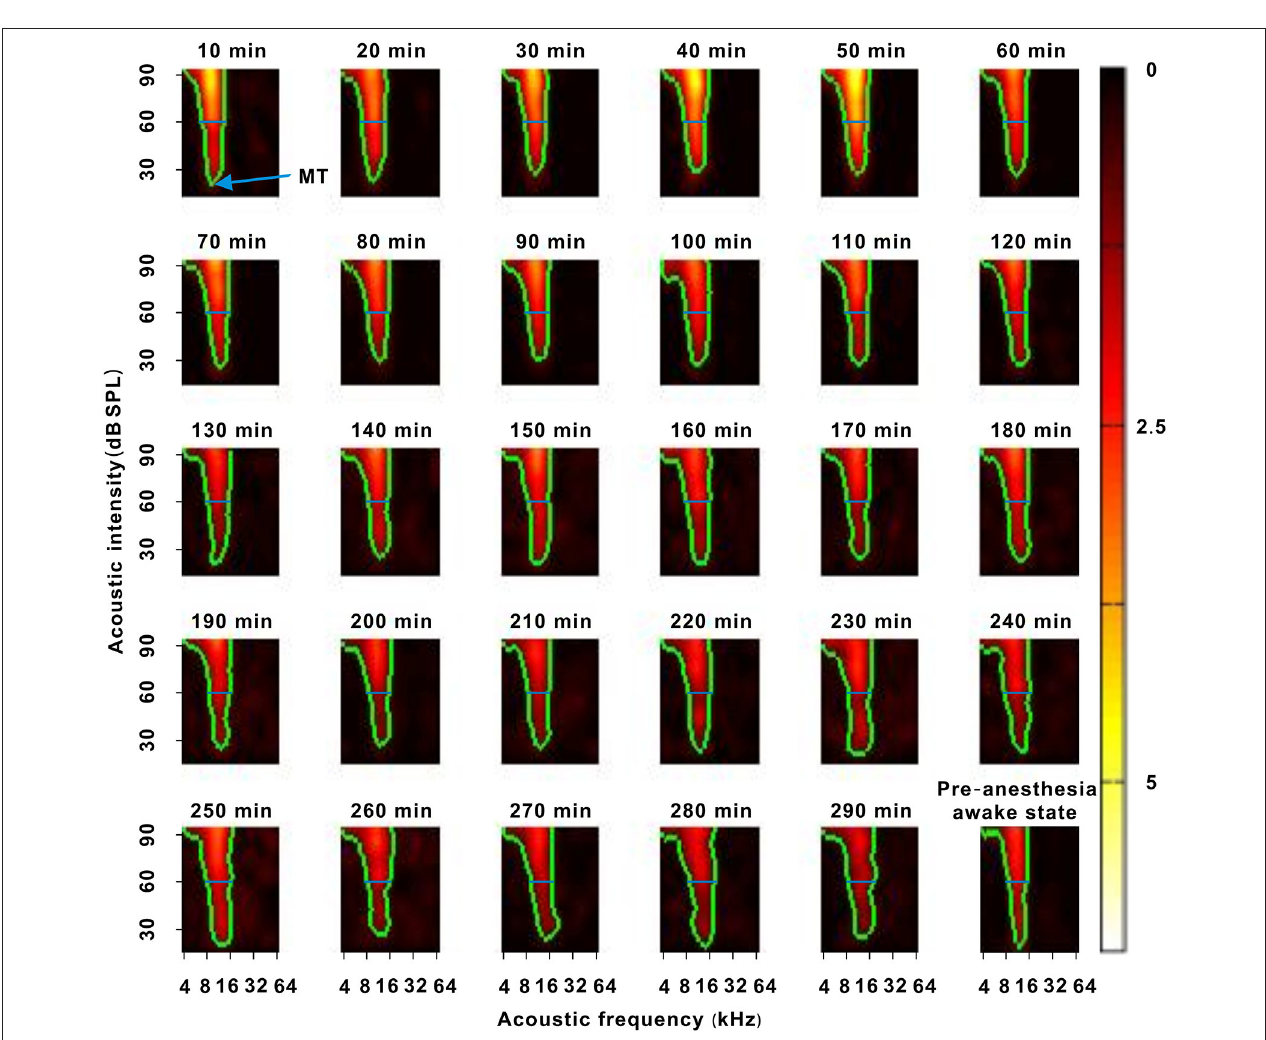
FIGURE 2 | A representative neuron with a change in response intensity. The 10–290min was the time after urethane anesthesia. Each green curve was the contour of the TRF. The blue arrow labeled the location of the MT. The blue lines labeled the location of 60 dB SPL. The last pseudocolor map in the bottom right corner was obtained under the pre-anesthesia awake